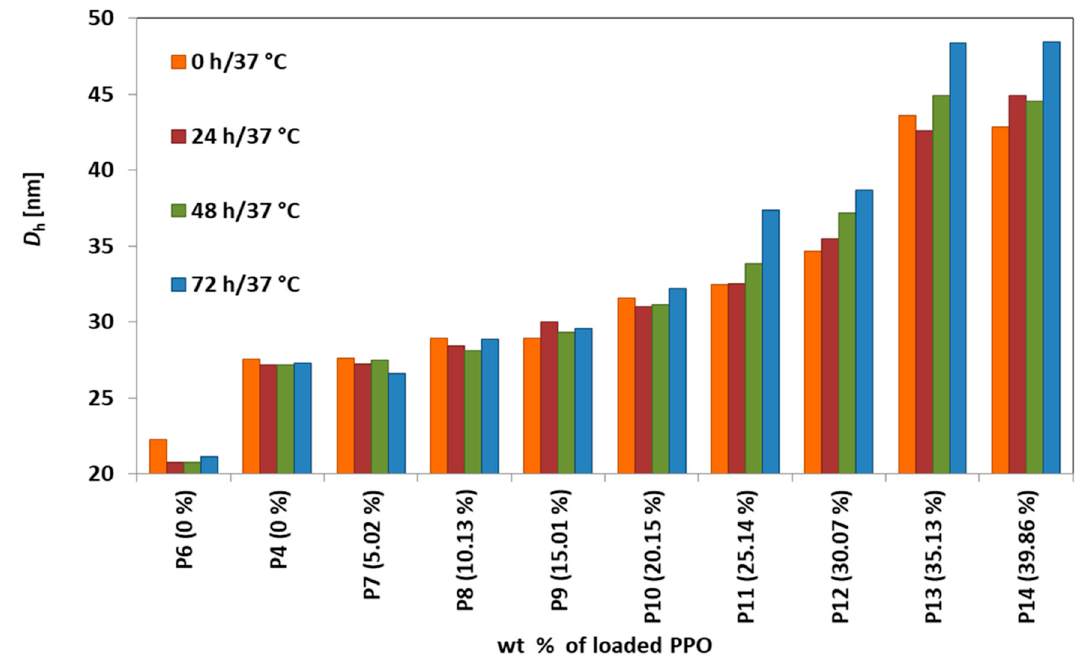
Figure 3. Size dependence of micelles P4, P6–P14 on the time of incubation, copolymer structure, and content of loaded PPO.